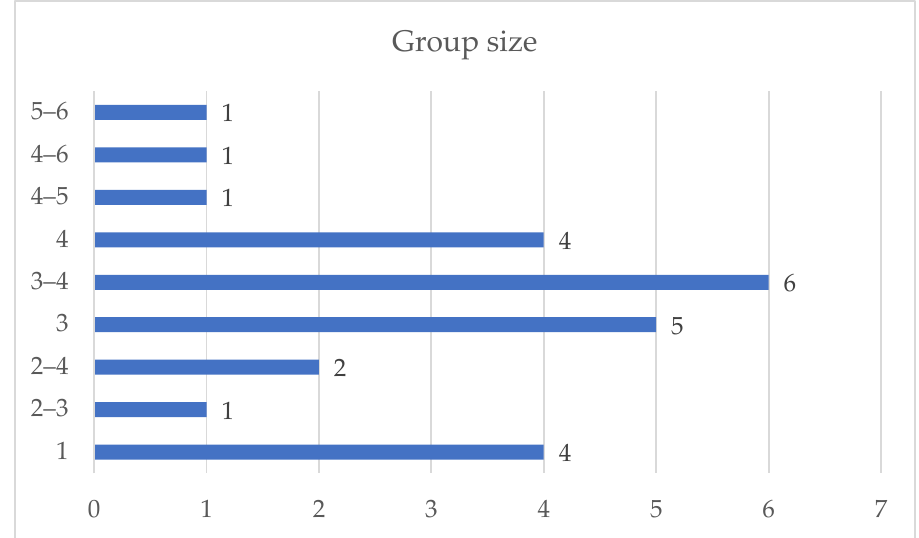
Figure 11. Group size of the empirical studies.